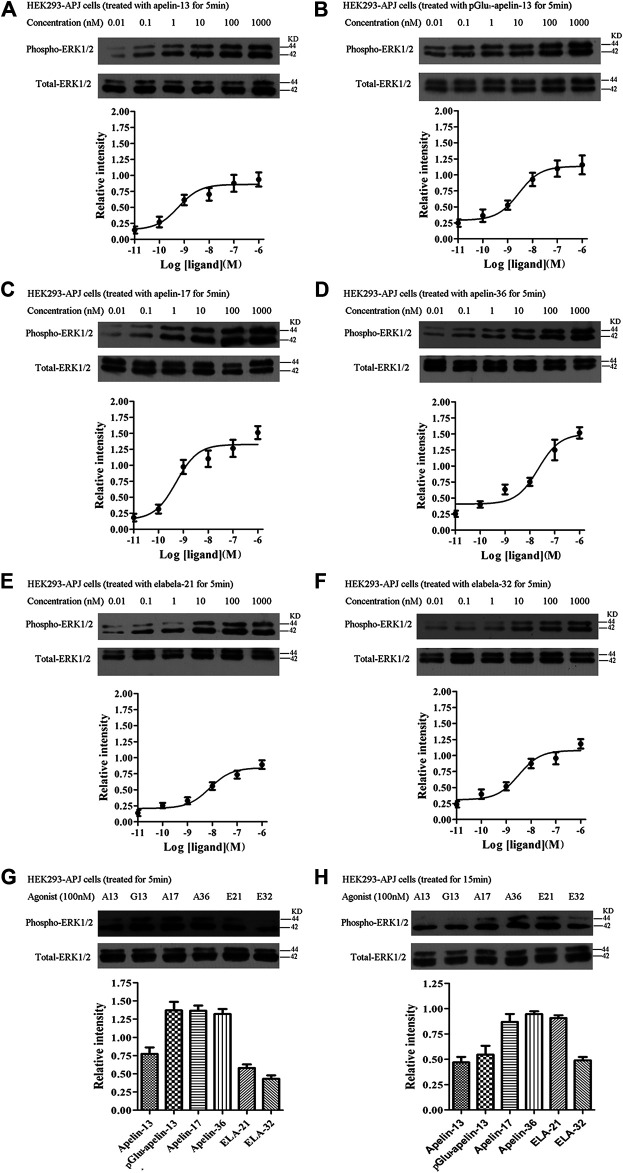
Changes of ERK1/2 phosphorylation in HEK293 cells with stable expression of APJ: (A–F) after 5-min stimulation by the six agonists in different concentrations (0.01–1,000 nM) (G and H) ERK was measured after 5 or 15 min stimulation with six peptides at a concentration of 100 nM. Levels of p-ERK, total ERK were determined by Western blot. The data represent means ± SEM of four independent experiments.